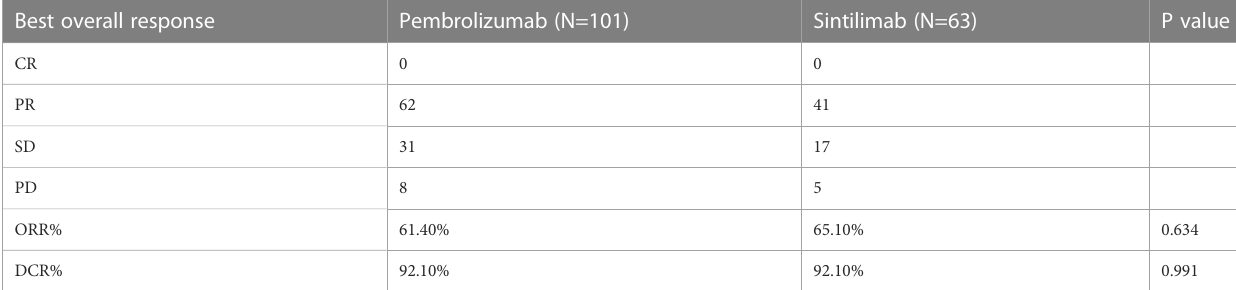
TABLE 2 Comparison of short-term clinical outcomes between the two groups. Best overall